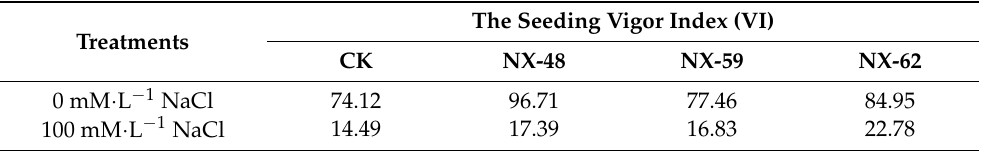
Table 1. The seedling viability index (VI) after inoculation with NX-48, NX-59, and NX-62 on the fifth day of salt stress.